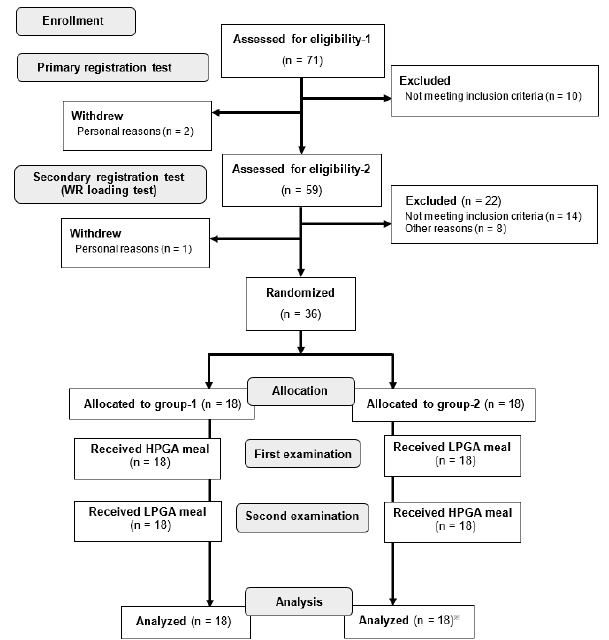
Figure 1. Study flowchart. Of the 71 candidates identified, 36 eligible individuals were randomly assigned to two groups. ※ All data for the second examination of one participant in group-2 were treated as missing data. LPGA: low-gamma-polyglutamic acid; HPGA: high-gamma-polyglutamic acid.